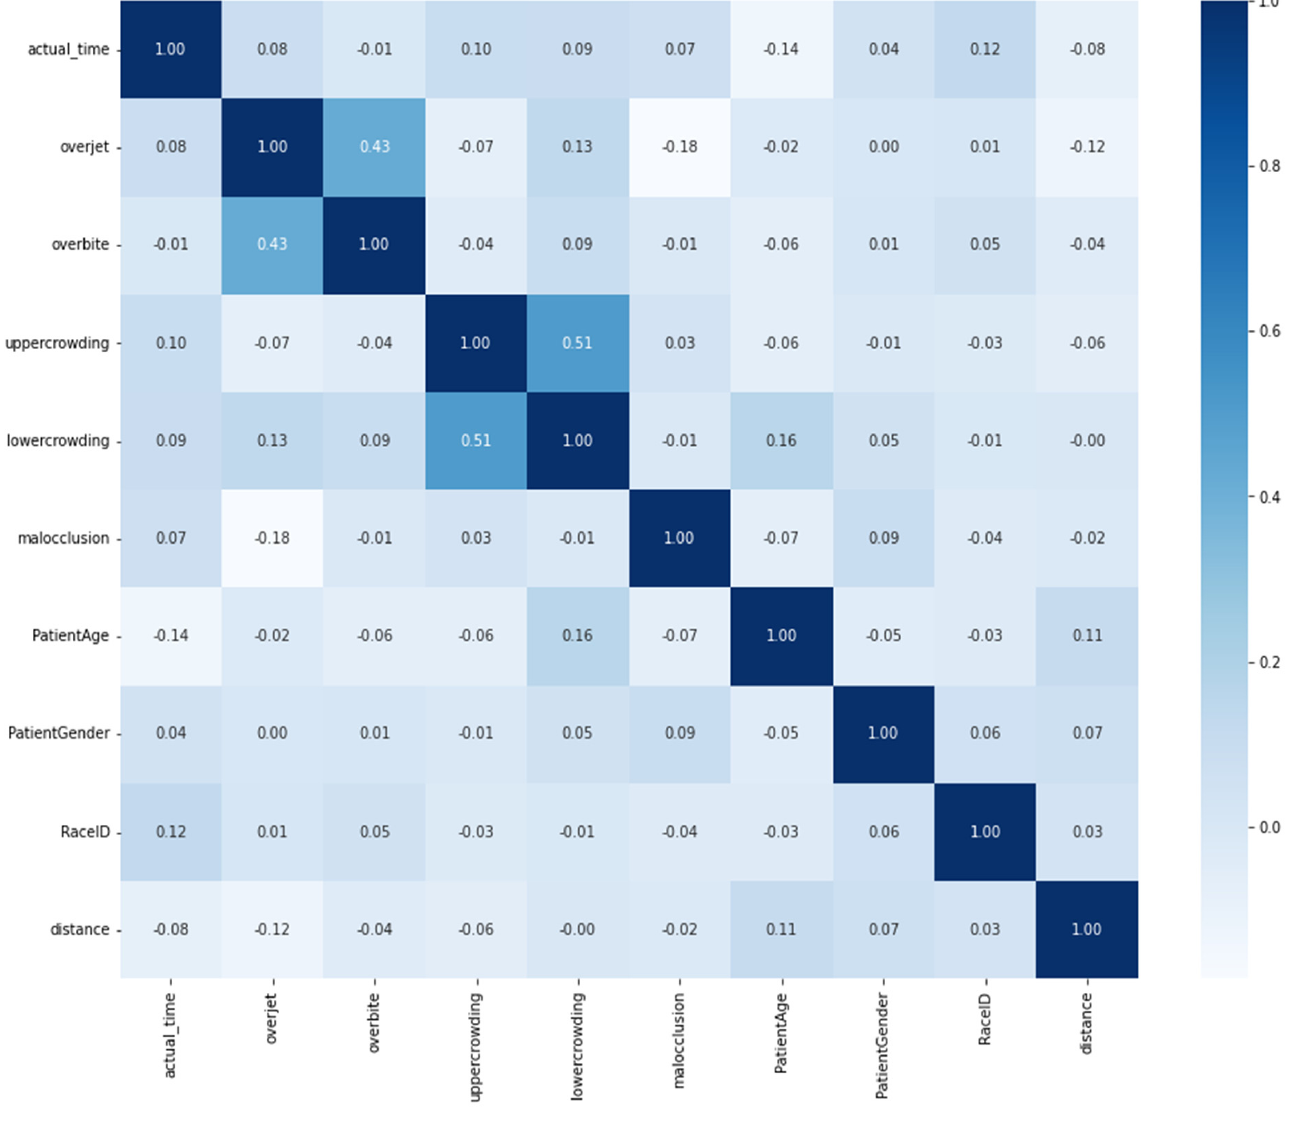
Table 2. Performance Comparison of the ML Models.